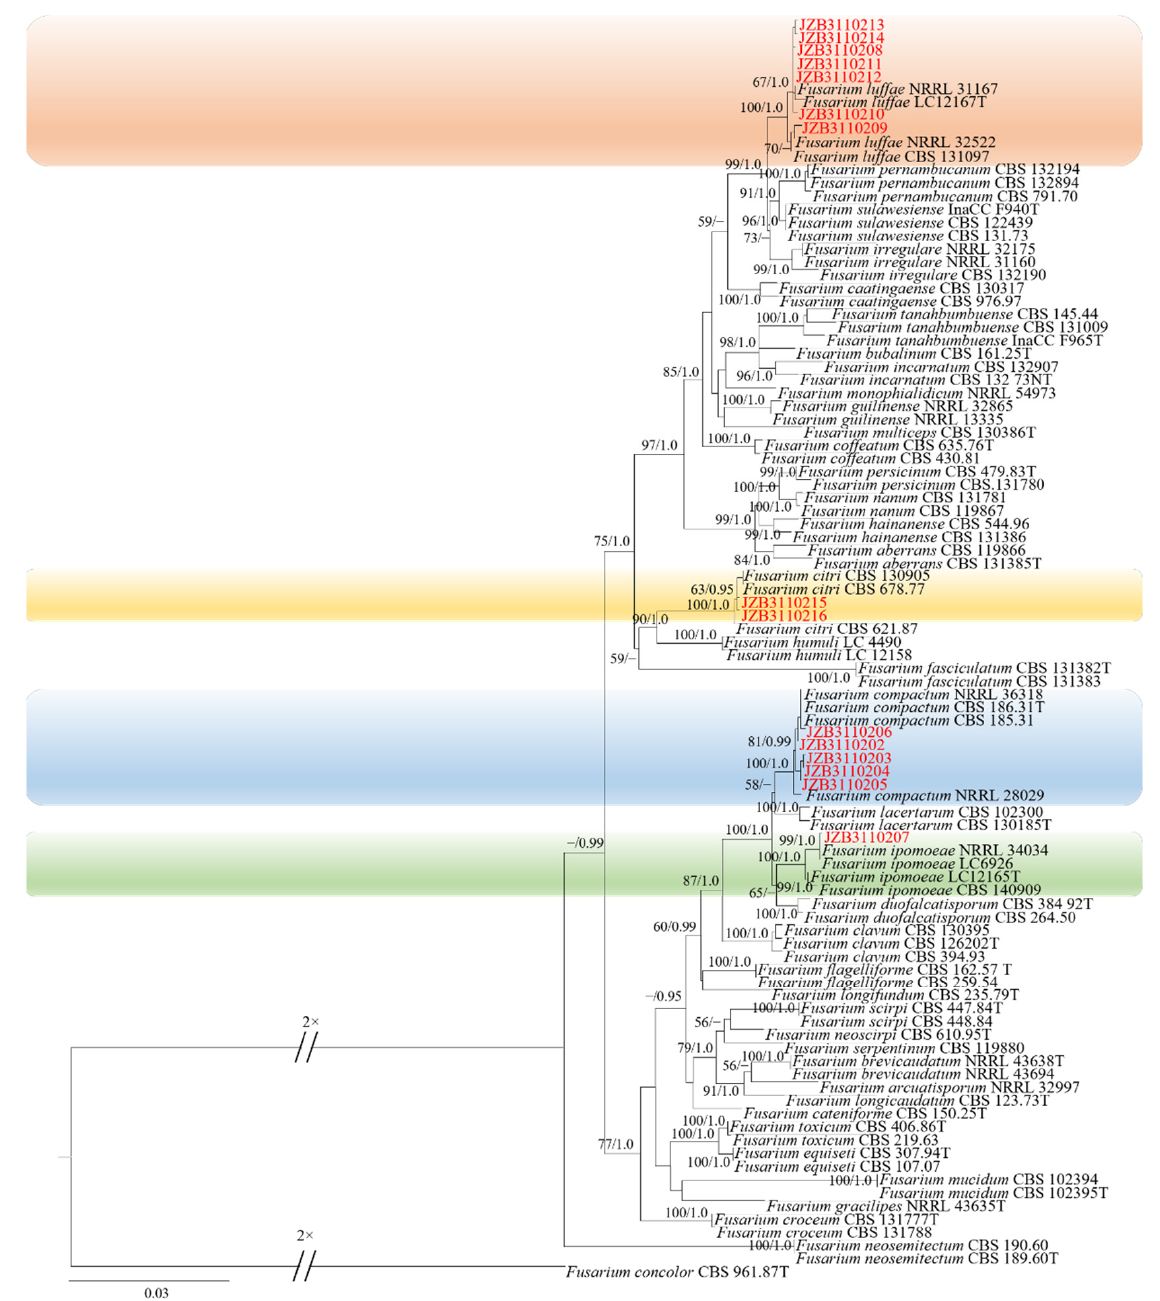
Figure 2. Phylogenetic tree generated by maximum likelihood analysis (RAxML) of FIESC based on the combined CaM , rpb2 and tef1 sequence data. The tree is rooted with Fusarium concolor (CBS 961.87). The best-scoring RAxML tree with a final likelihood value of –11,974.052080 is presented. The matrix had 701 distinct alignment patterns, with 7.69% of undetermined characters or gaps. Estimated base frequencies were as follows: A = 0.258901, C = 0.260331, G = 0.245699, T = 0.235069; substitution rates AC = 1.002698, AG = 4.065670, AT = 1.349366, CG = 0.882966, CT = 10.506153, GT = 1.000000; gamma distribution shape parameter α = 0.751525. ML bootstrap support values ≥ 50% and Bayesian posterior probabilities (BYPP) ≥ 0.95 are given near the nodes. The scale bar indicates 0.03 changes per site. Isolates belonging to this study are given in red.